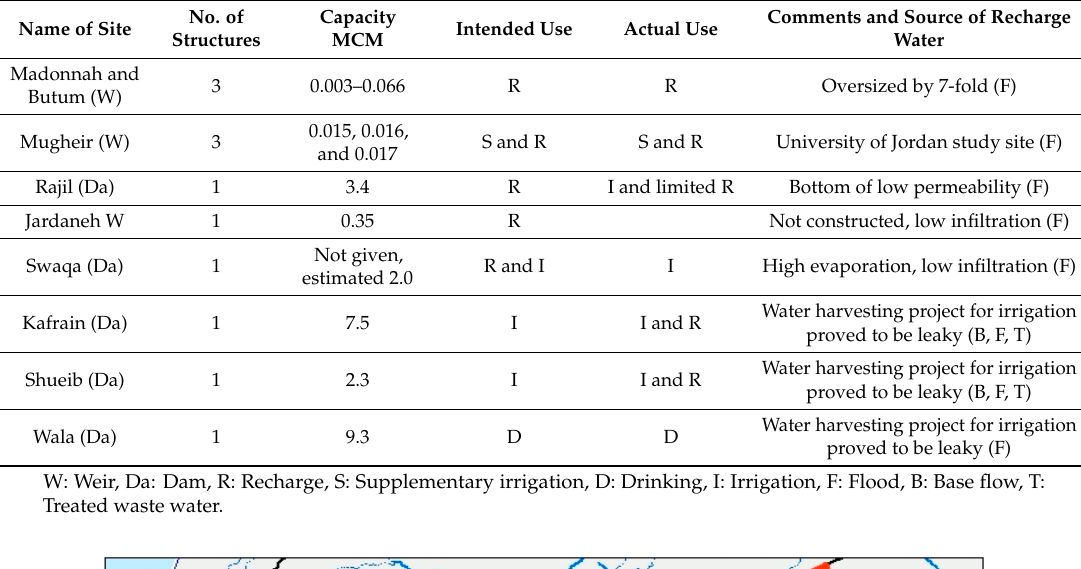
Table 2. Existing and studied (but not yet implemented) managed aquifer recharge projects in Jordan.